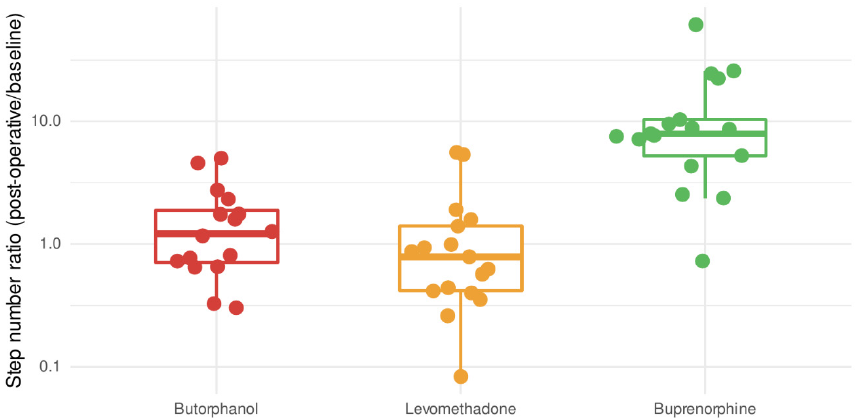
Figure 5. Step number of the treatments (BUT in red, LEV in yellow, BUP in green) normalized by the baseline values (step counts over 12 h without treatment) represented with a Tukey boxplot. Individual data are shown as points. The box and whiskers represent the interquartile range (IQR) and 1.5 IQR respectively. The thick horizontal line is the